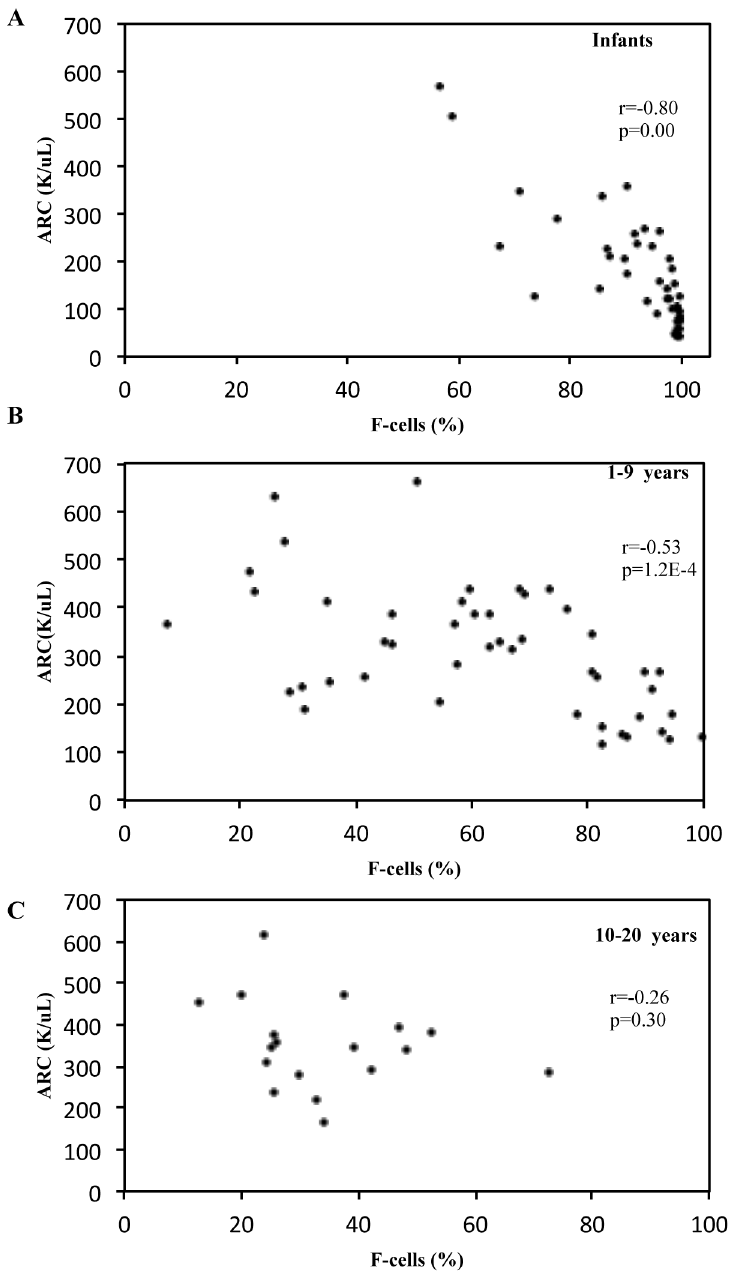
Fig 2. Relationship of ARC and F-cells by Age Group. A. Correlation of F-cell % and ARC in infants with SCA (less than 1 year of age) at steady state. B. Same correlation with children with SCA who are between 1 and 9 years of age and C. between 10 and 20 years of age. ARC, Absolute Reticulocyte Count. Each dot represents a steady state value for a separate patient.